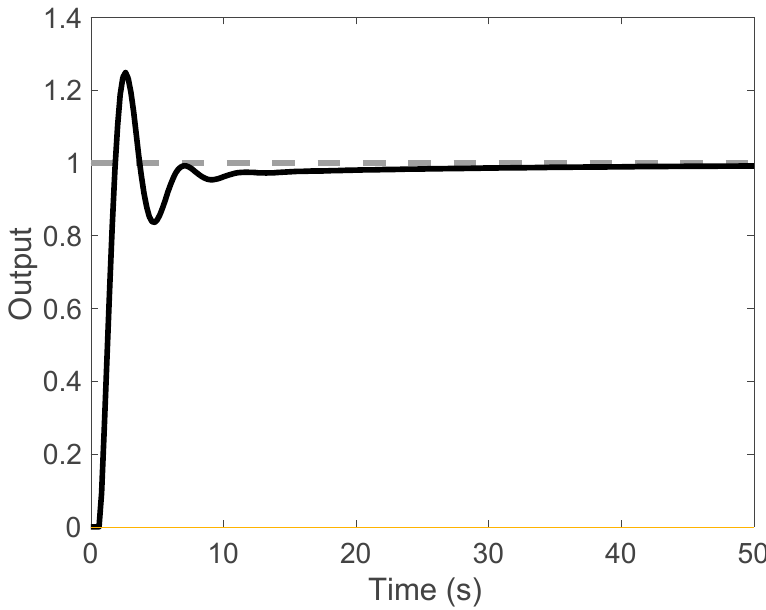
Figure 11. Reference tracking results for a first-order plus dead-time process.